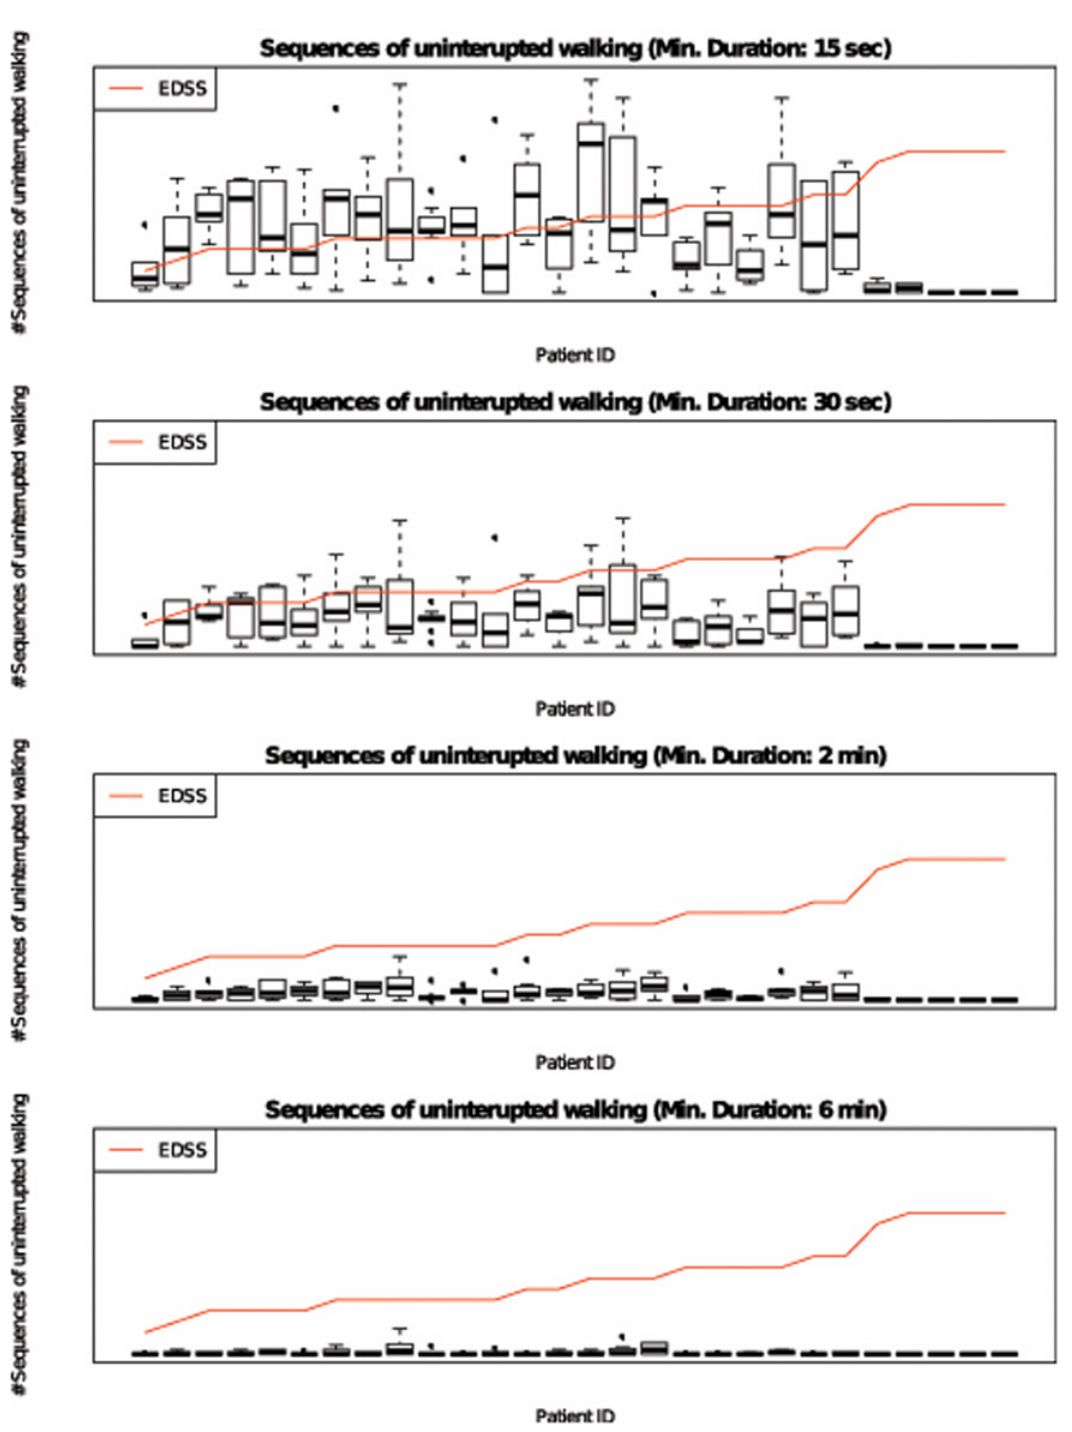
Fig 1. Sequences of 15s / 30s / 2 min / 6 min uninterrupted walking in real life. Mean number of uninterrupted walking sequences per day for each patient during a 7-day assessment of real life mobility with a mobile accelerometer. Data presented as boxplots with median, 25%-/75%-quantiles and whiskers representing